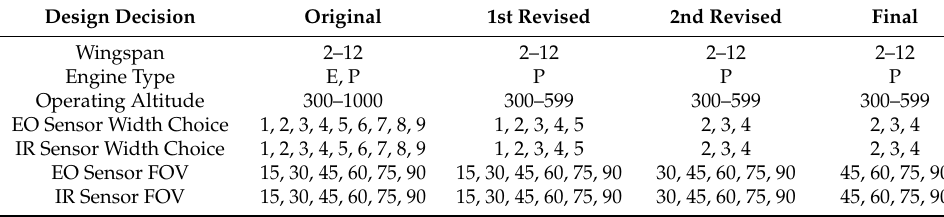
Table 3. Summary of Tradespace Refinement Results for All Design Teams.